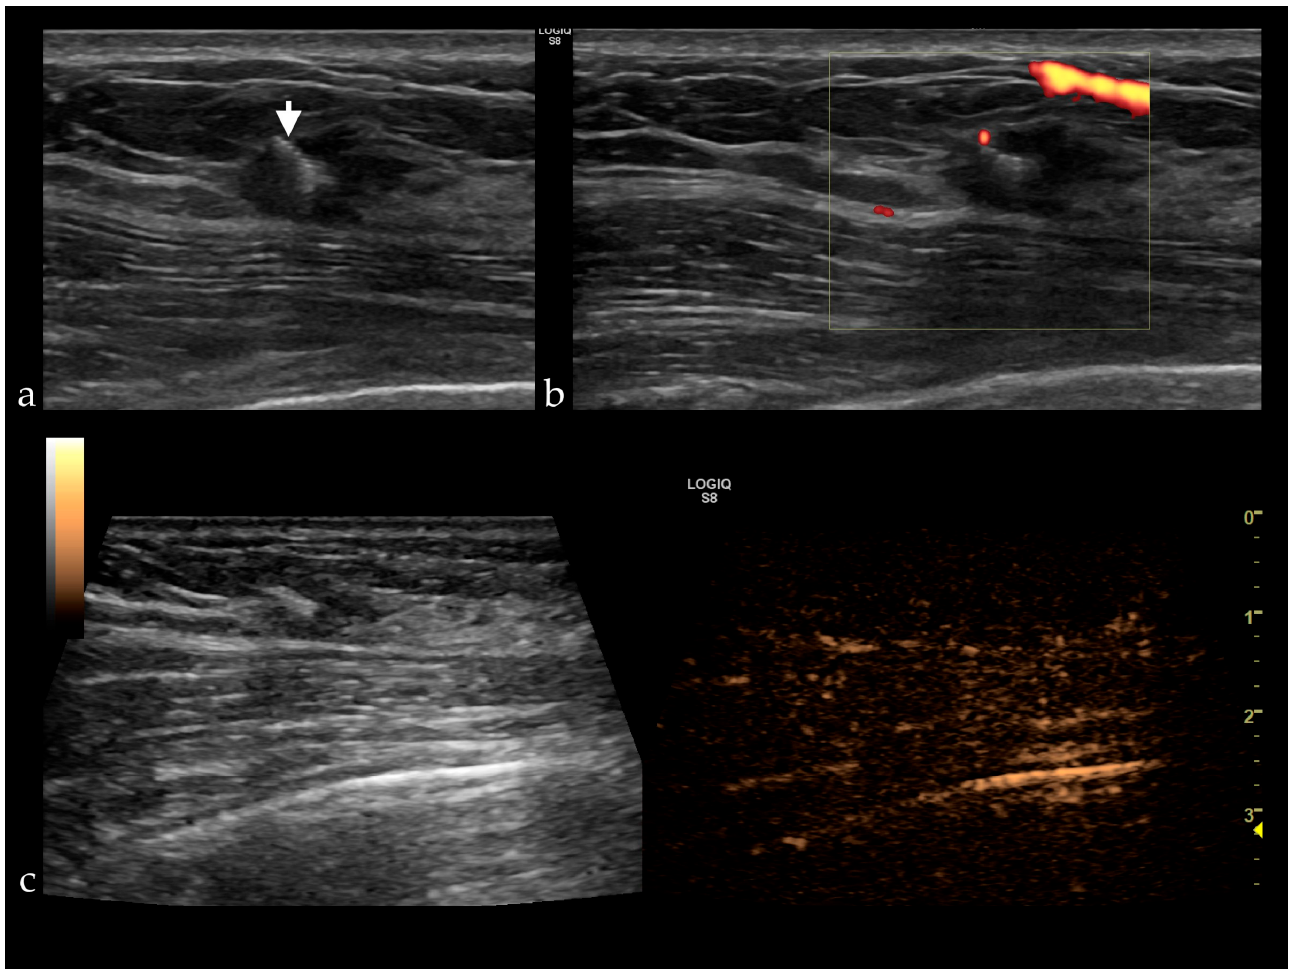
Figure 2. ( a ) Gray-scale ultrasound reveals a HER2 positive breast cancer presenting as a hypoechoic, non-circumscribed lesion with a clip placed in the center (white arrow), without vascularization ( b ) and no enhancement after contrast administration ( c ).